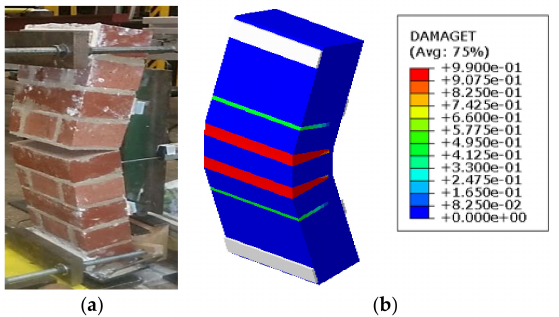
Figure 15. Failure pattern of MP00: ( a ) experimental; ( b ) FE model.